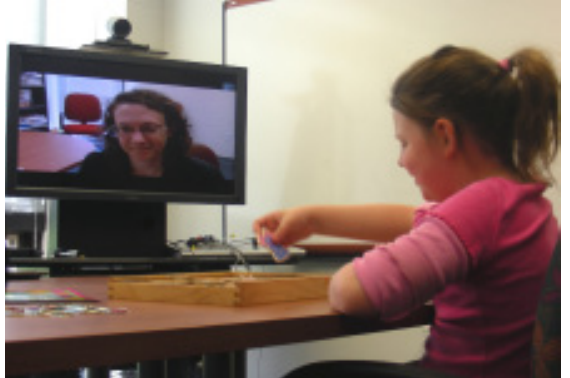
Figure 2. Full-screen image of SLP camera image as picture-in-picture